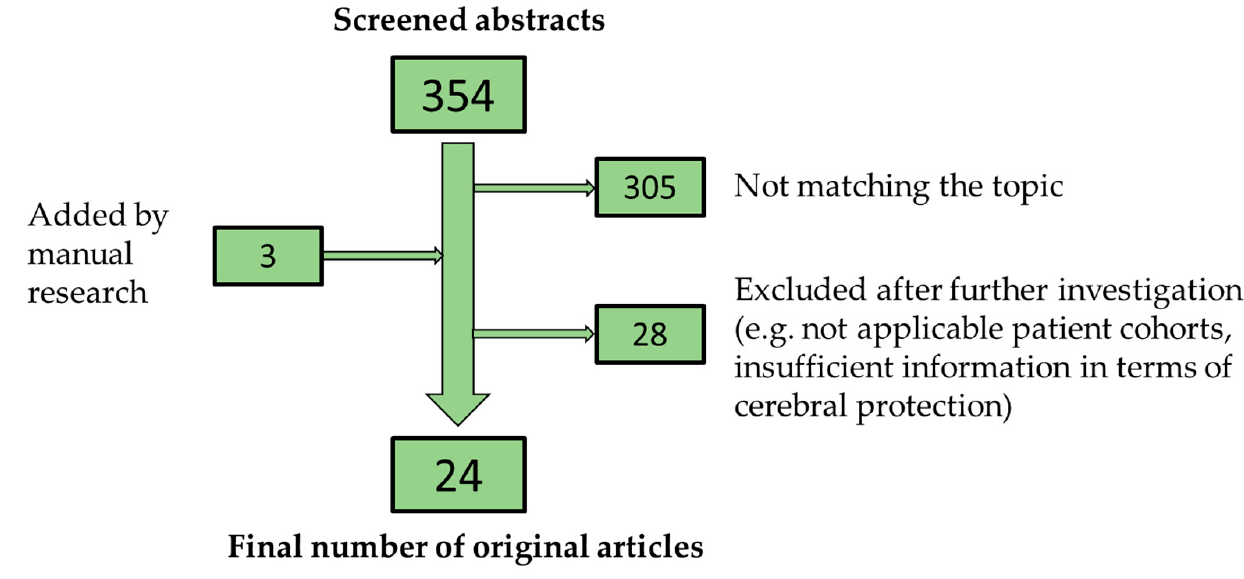
Figure 1. Process of the literature research.